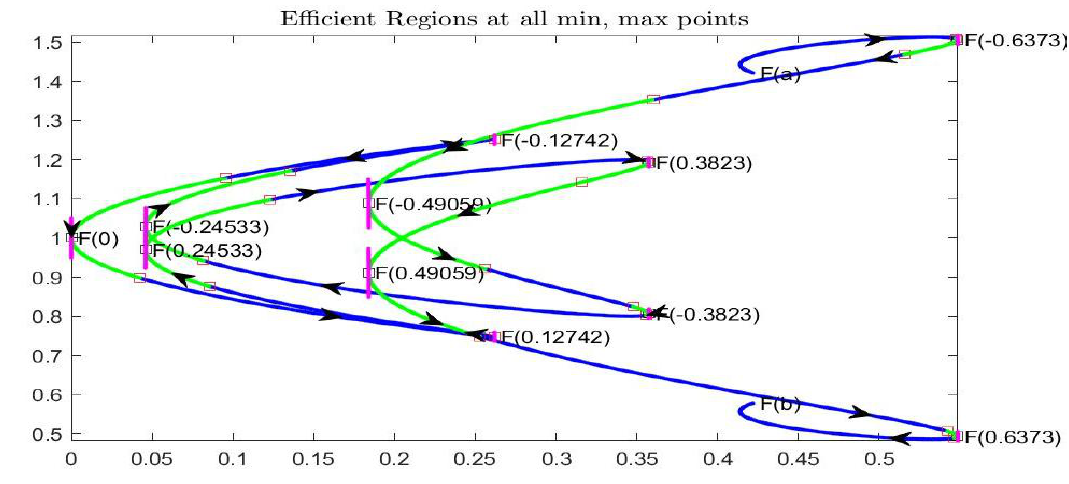
Figure 18. Complete Example: function F ( x ) is represented in midpoint form, and all local minima (five points) and maxima (six points) are marked together with corresponding efficient